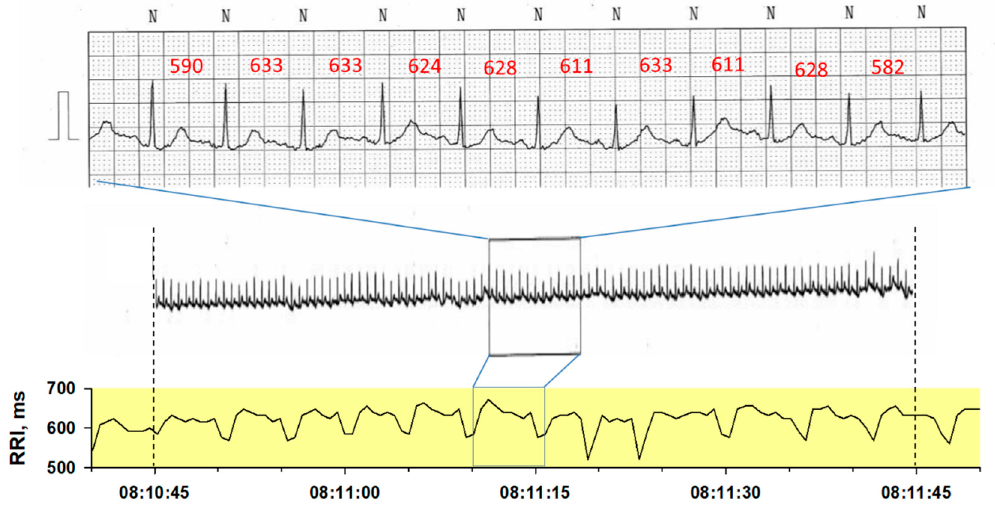
Figure 3. Age-dependent changes in HRV frequency components. Made from data from a previous study [4].